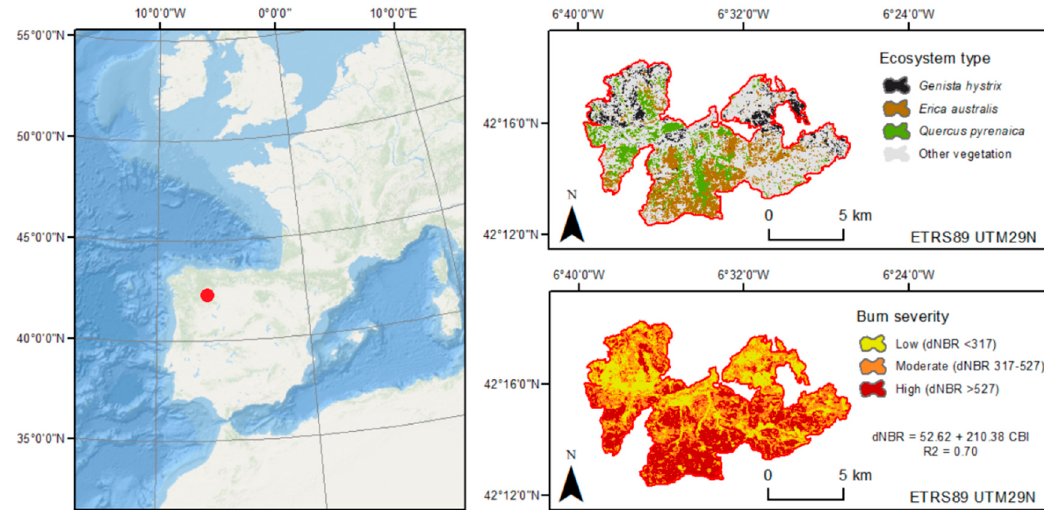
Figure 1. Location of the study area in the Iberian Peninsula (left). Panels on the right show the type of ecosystems in the fire perimeter (top) and burn severity levels (bottom) [69].